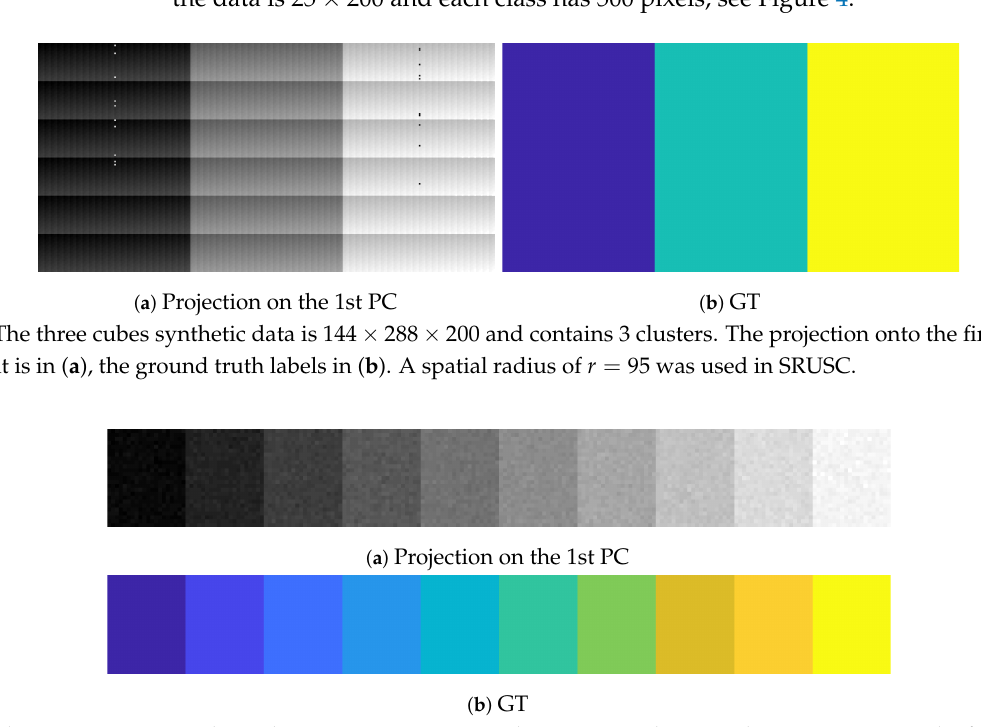
Figure 4. The ten Gaussian synthetic data is 25 × 200 × 100 and contains 10 clusters. The projection onto the first principal component is in ( a ), the ground truth labels in ( b ). A spatial radius of r = 20 was used in SRUSC.